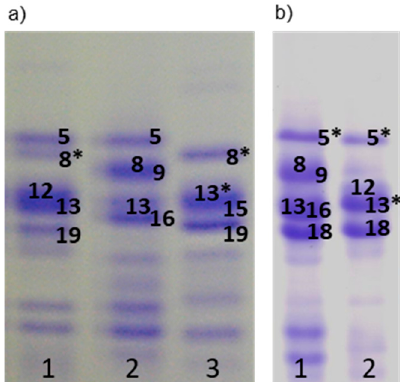
Figure 2. Electrophoretic patterns of durum wheat landraces and standard varieties illustrating some of the low molecular weight glutenin subunits (LMW-GS) observed in the accessions under study. ( a ) Accessions BGE013718 and BGE019300 (lanes 1 and 3) and standard durum wheat ‘Langdon’ (lane 2). ( b ) Standard durum wheat ‘Fanfarron’ (lane 1) and accession BGE018657 (lane 2).